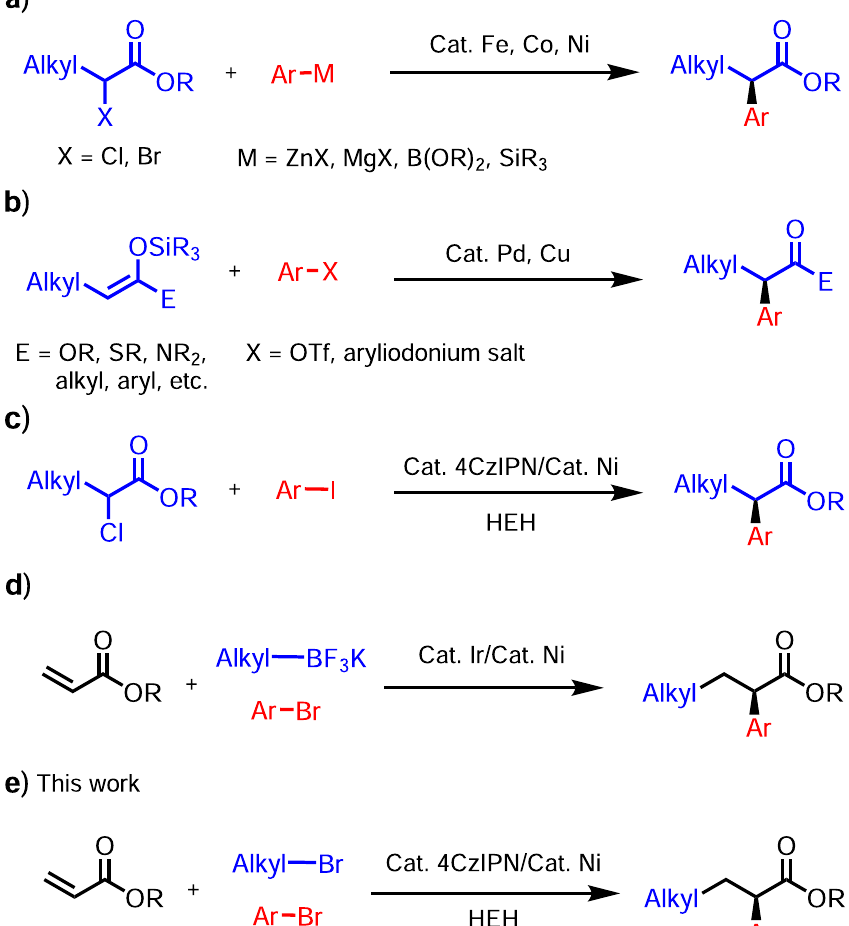
Fig. 1 Transition-metal-catalyzed asymmetric coupling reactions to synthesize NSAID derivatives. a The classical asymmetric cross-coupling with organometallic reagents. b Transition metal catalyzed asymmetric arylation of enol silane derivatives. c Nickel-photoredox co-catalyzed asymmetric reductive arylation of racemic α -chloro esters. d A complementary photoredox/nickel catalyzed enantioselective carboarylation of alkenes. e This work: Nickel/photoredox catalyzed reductive asymmetric alky arylation of